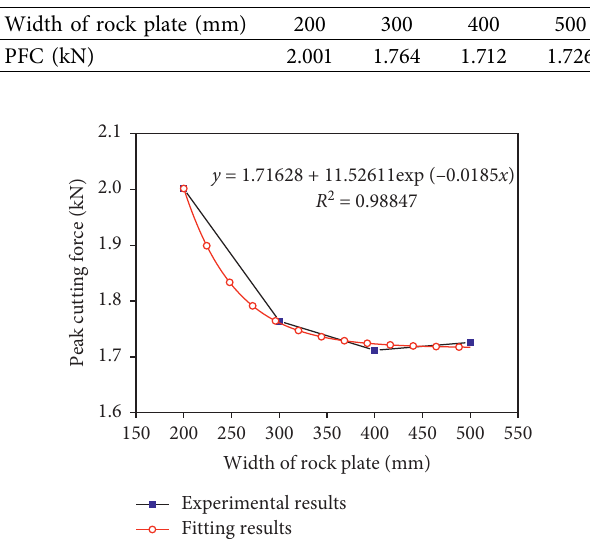
Figure 19: The relationship between PCF and width of rock